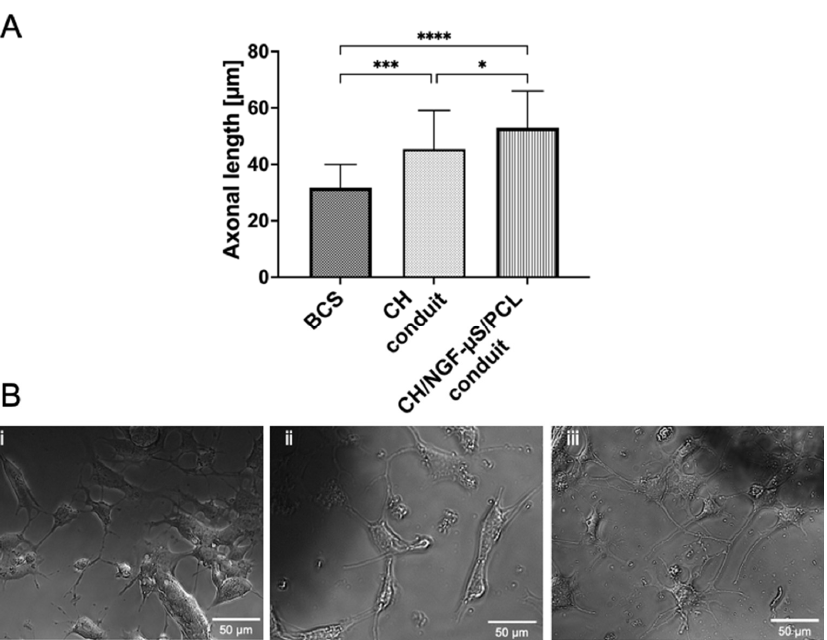
Figure 8. The influence of CH and CH/NGF- µ S/PCL conduits on mHippoE-18 cells regarding their ability to stimulate axon elongation ( A ) and morphology ( B ) evaluated by light microscopy: mHippoE-18 cells grown in the presence of commercially available biomaterial BCS (i), CH conduit (ii), and CH/NGF- µ S/PCL conduit (iii). Conduits are visible as darker areas in the pictures.